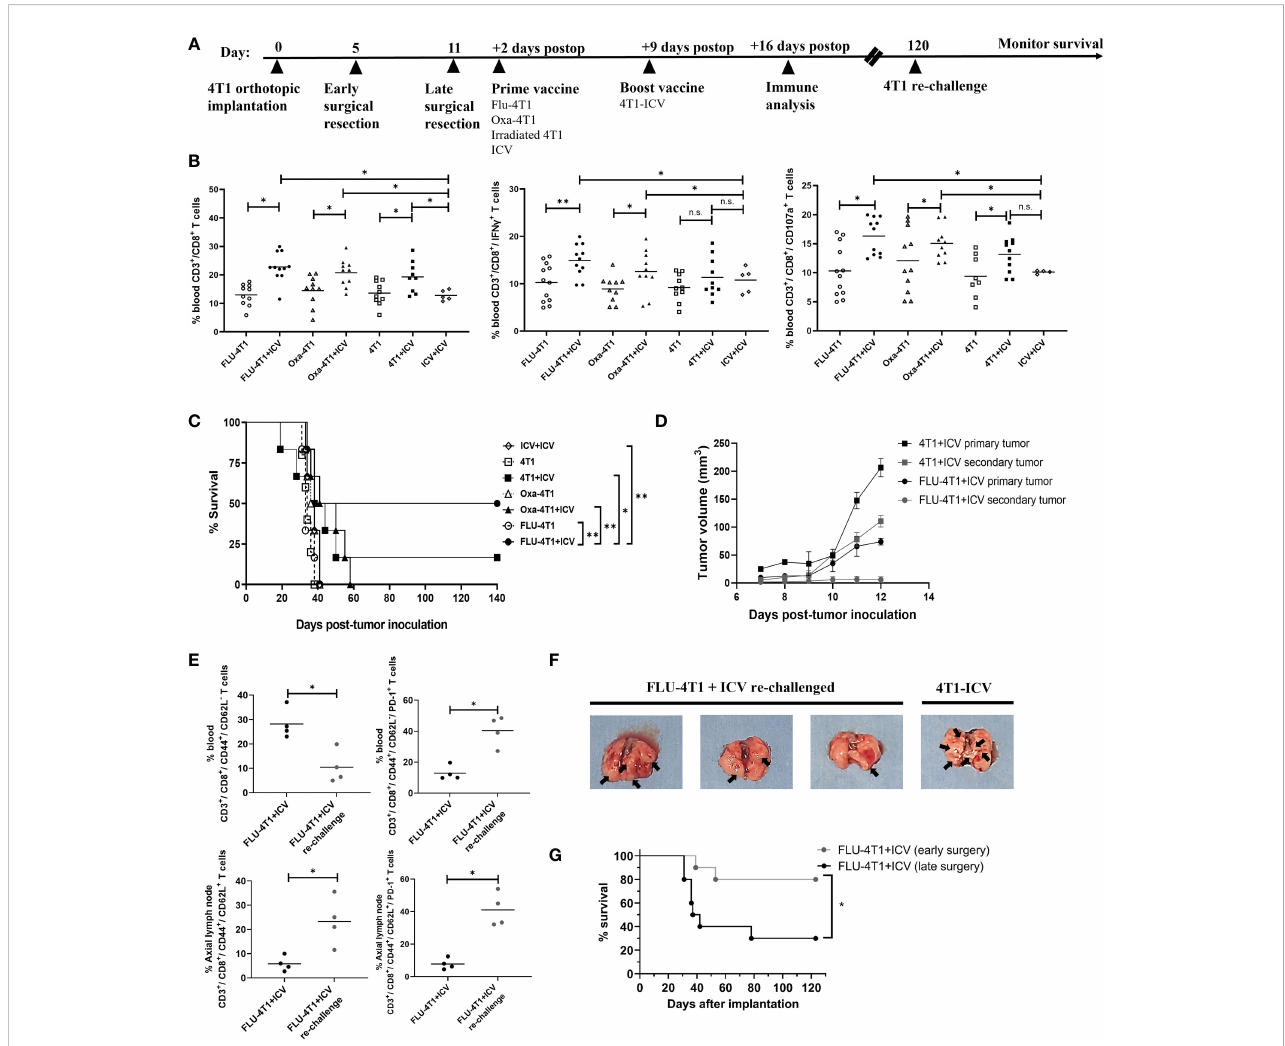
FIGURE 5 Heterologous prime-boost vaccination improves survival in the BALB/c-4T1 model of TNBC. (A) Timeline of in vivo BALB/c-4T1 experiment. BALB/c mice were orthotopically implanted with 1x10 5 4T1 cells followed by a complete primary tumor resection on indicated days. Two days postoperatively, mice received 1 dose of the prime vaccine in the cleared mammary fat pad (FLU-4T1, Oxa-4T1, irradiated 4T1, ICV). Nine days postoperatively, mice received their 4T1-ICV boost vaccine. Immune functional analyses, re-challenge and monitoring were performed as indicated. (B) Immune cell suspensions from the peripheral blood of mice following indicated treatments were stained with T cell markers (CD3 + , CD8 + , IFN g + , CD107a + ) and analyzed by fl ow cytometry. (C) Kaplan-Meier survival analysis of mice receiving prime-boost ICV. n=10-12 mice/group. *P < 0.05; **P < 0.01; (n.s., no signi fi cance), log- rank test. (D) Tumor growth measurements comparing re-challenged 4T1 tumors with their corresponding primary tumor from 4T1-ICV and FLU-4T1- ICV treatment cohorts. (E) Flow cytometry analysis of central memory T cells in the axillary lymph node and effector memory T cells in the blood of FLU- 4T1+ICV treated cohort before and after re-challenging with 4T1 tumors. (F) Representative lung pictures from FLU-4T1+ICV re-challenged and 4T1-ICV treated cohorts. (G) Kaplan-Meier survival analysis of mice receiving early vs. late surgery and prime boost ICV. n=10-12 mice/group. *P < 0.05; **P < 0.01; (n.s., no signi fi cance), log-rank test. All fl ow cytometry data are representative of three similar experiments where n=4 mice/treatment, *P < 0.05; **P < 0.01; (n.s., no signi fi